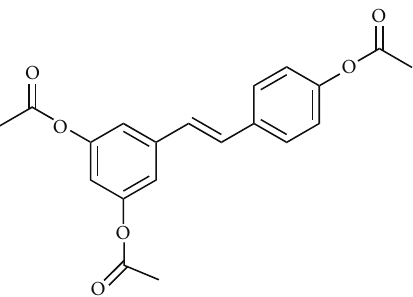
Figure 1: The chemical structure of 3,5,4 󸀠 -tri-O-acetylresveratrol